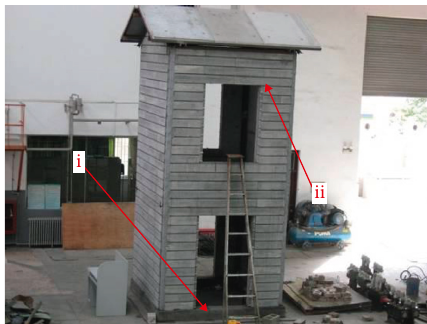
Figure 3: Full-scale two-story experimental model: (i) ground beam and (ii) prefabricated lightweight steel